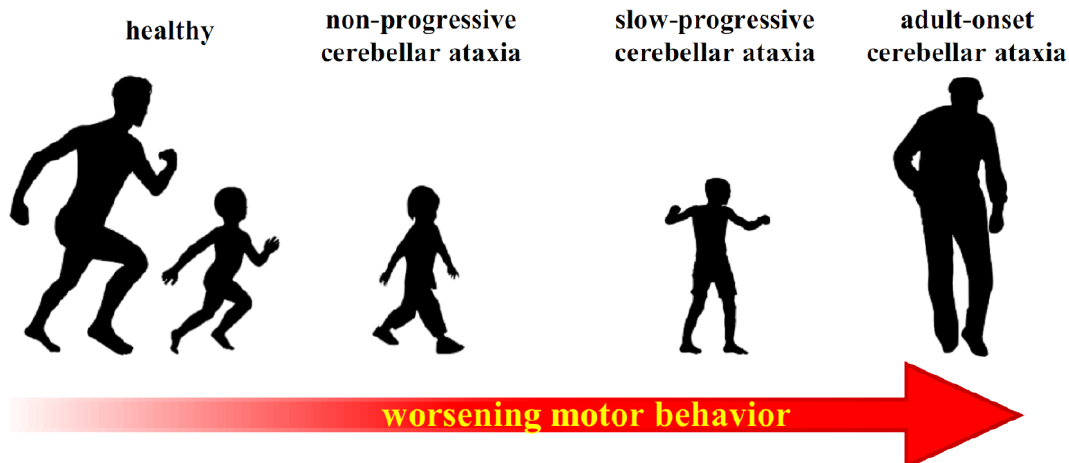
Figure 2. Role of the cerebellum in the ontogenesis of the APA control. Cerebellar deficits interfere with the correct development of postural control. The later the appearance of the cerebellar deficit, the weaker seems to be the ability of the CNS to develop a compensatory strategy. This is particularly apparent when the disease has a progressive course, since it contrasts with the strategy consolidation.